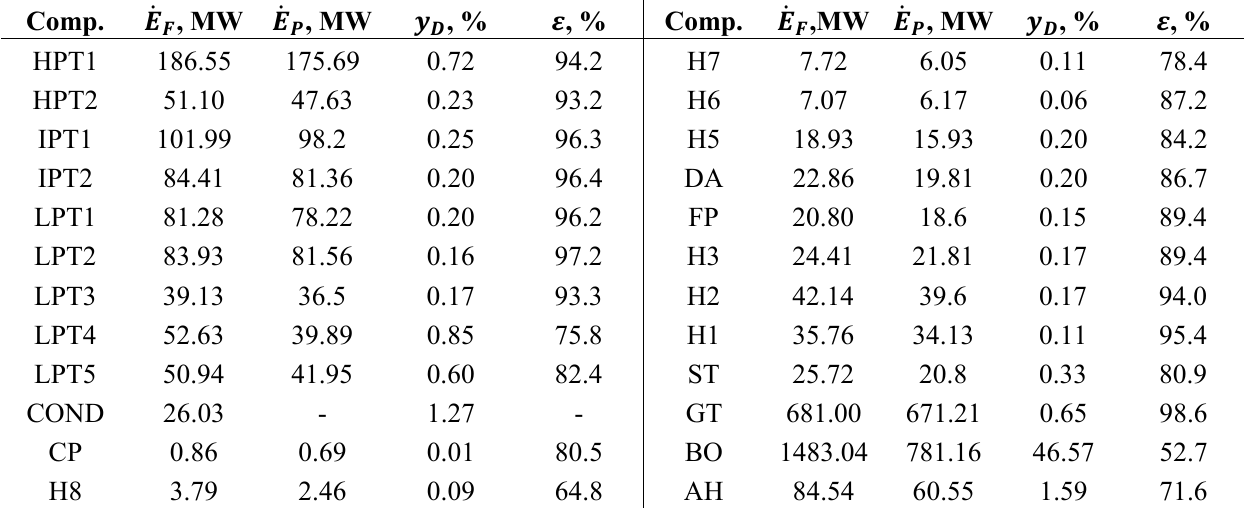
Table 4. Results from the conventional exergy analysis at the component level. Comp.